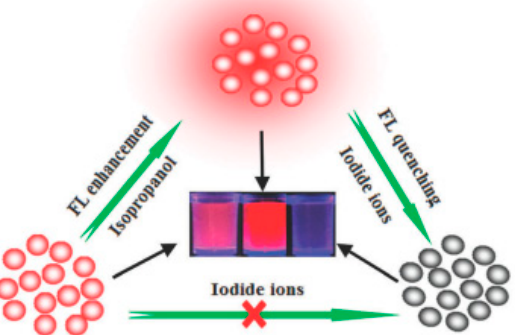
Figure 8. Schematic illustration of isopropyl alcohol (IPA)-triggered fluorescence enhancement of the Ag NCs and then fluorescence turning-off induced by iodide ions (Copyright Ref [102], Royal Society of Chemistry).